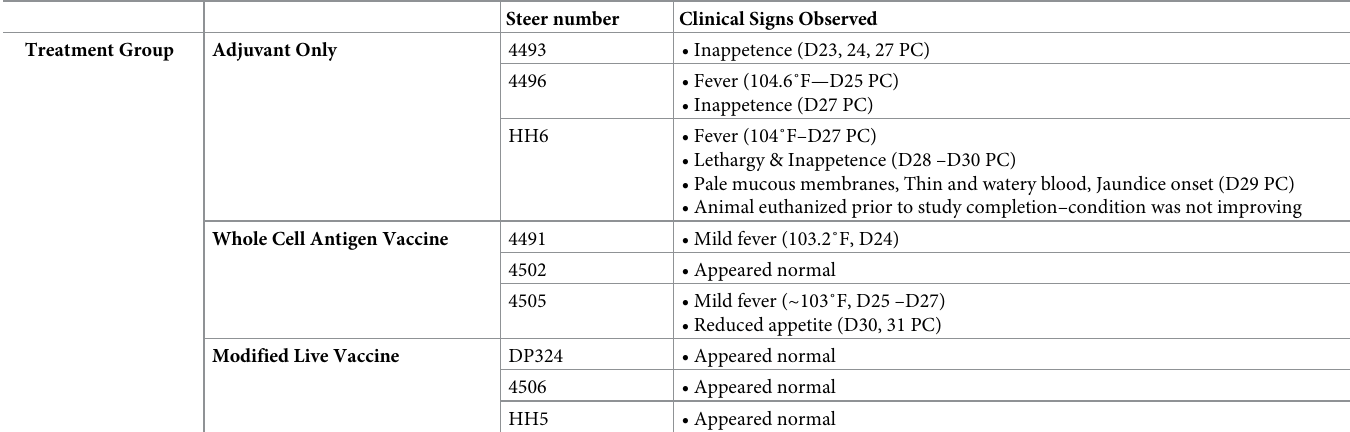
Table 1. Clinical signs observed for all A . marginale vaccine study